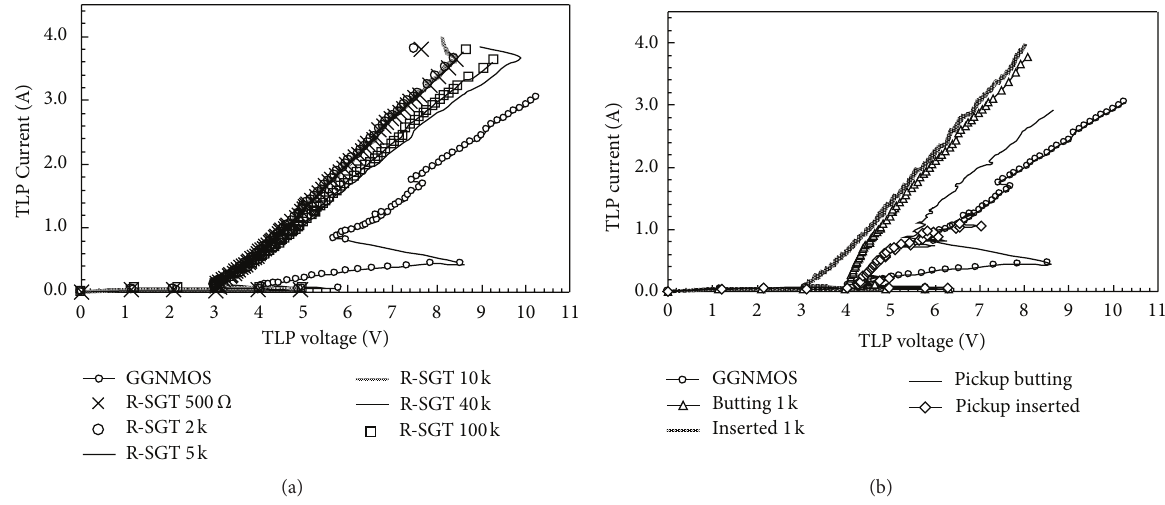
Figure 3: (a) The TLP 𝐼 - 𝑉 curve comparison among the GGNMOS and resistance SGTNMOS devices with normal pickup style. (b) The TLP 𝐼 - 𝑉 curve comparison among the GGNMOS and resistance SGTNMOS with special pickup